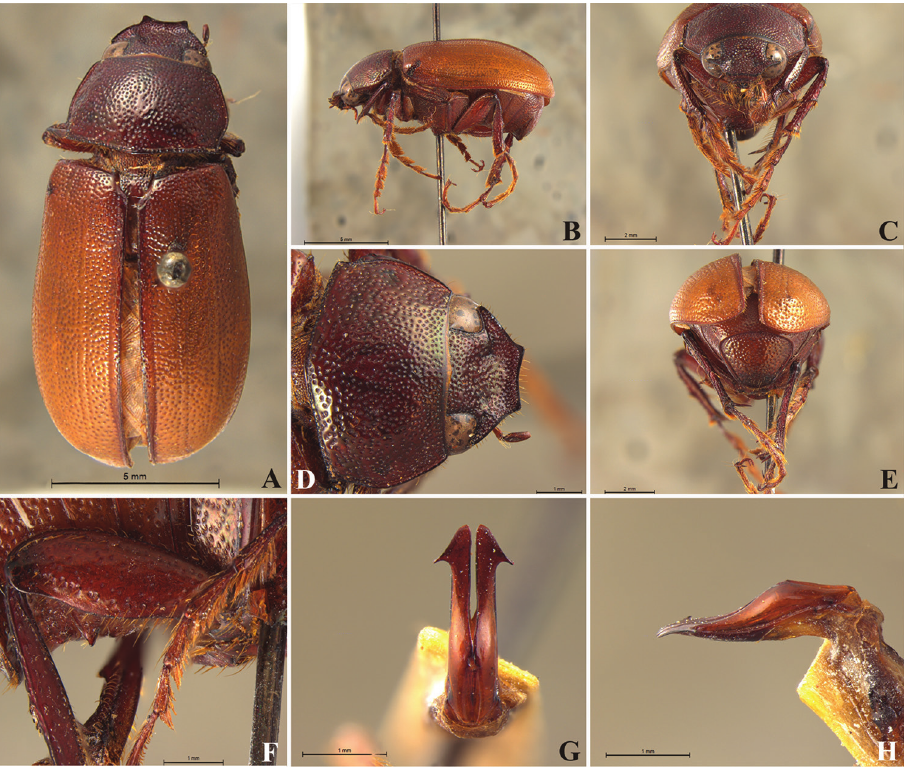
Figure 76. Liogenys testaceipennis Moser A Dorsal view B Lateral view C Frontal view D Clypeus and pronotum E Pygidium F Abdomen, lateral view G Parameres, dorsal view H Parameres, lateral view. convex in males, straight in females; male mesotibia quadrate in cross section, sub- quadrate to cylindrical in females; pygidium varies from flat to convex, as wide as it is long; pygidial disc bristled only on apex. In males, metafemur medially produced